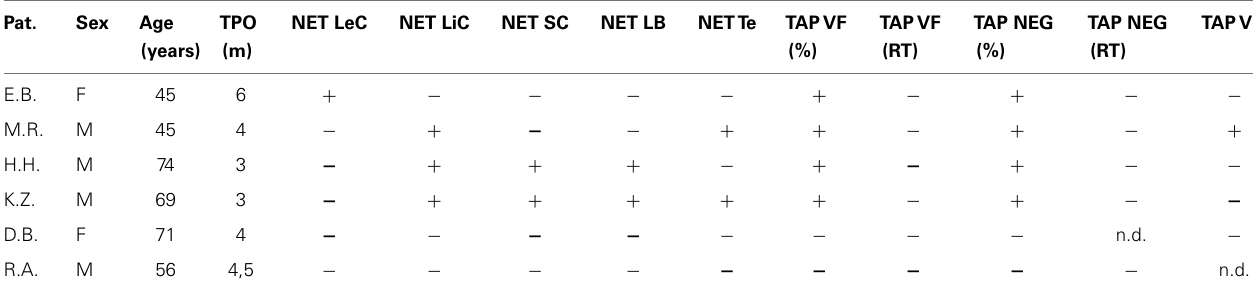
Table 1 | Patient characteristics and test results at the first pretest “pre 1.”